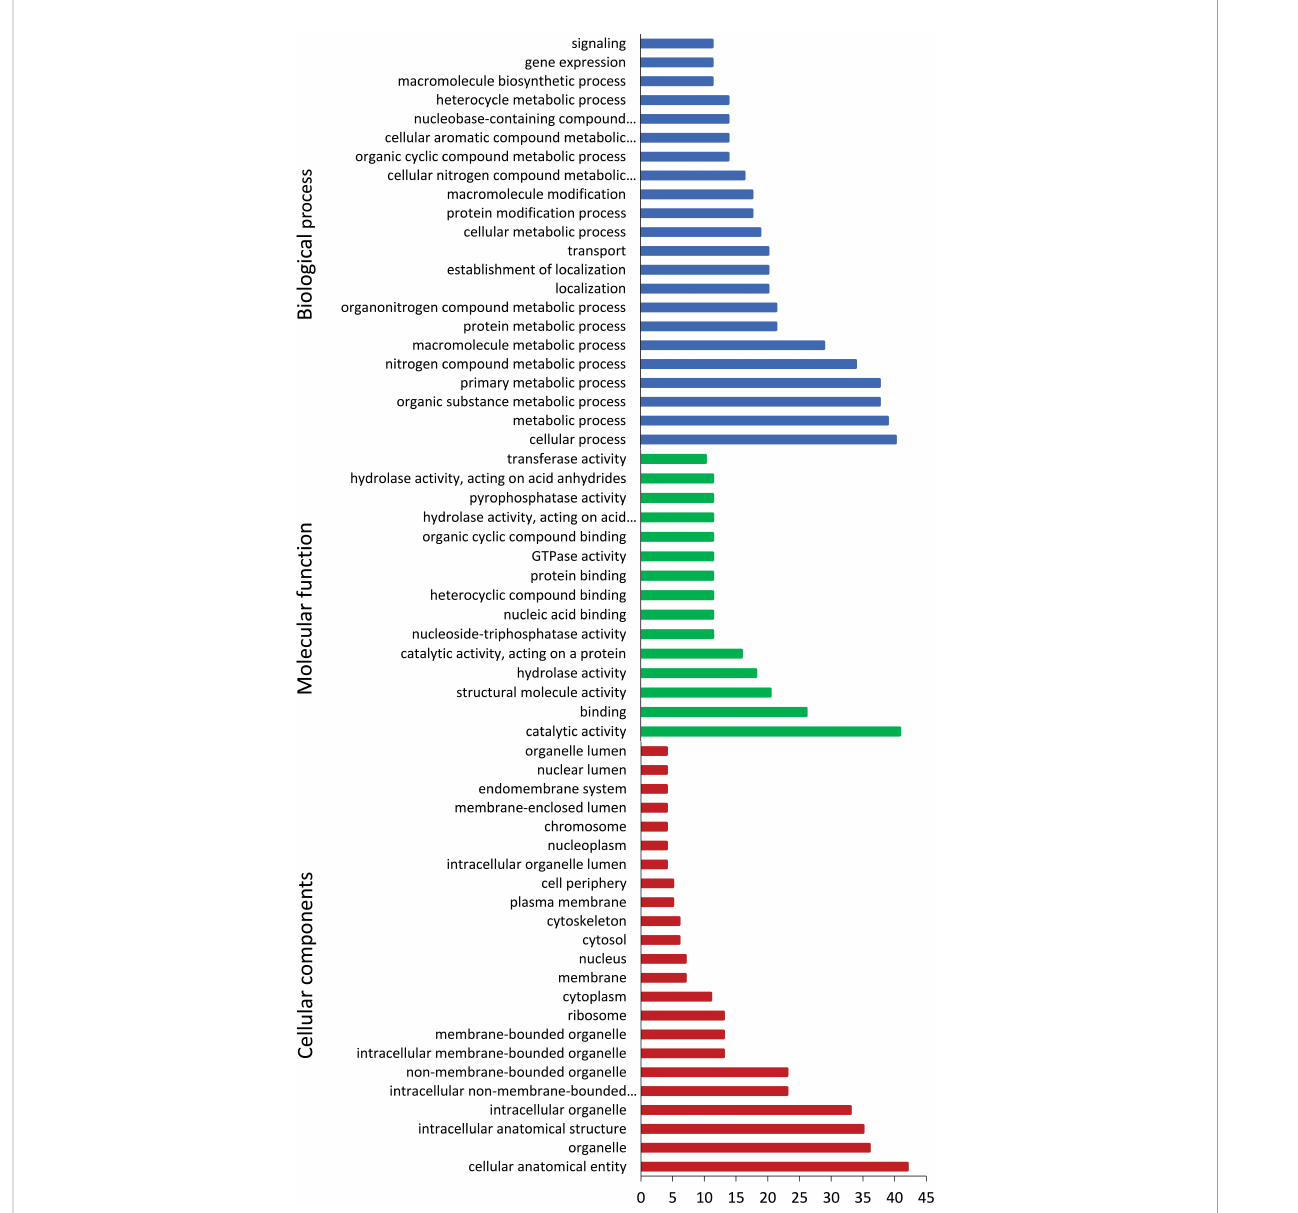
FIGURE 4 Gene ontology annotation of Tetracapsuloides bryosalmonae in vivo -induced genes. Most frequent level 2 GO terms in T. bryosalmonae IVI genes, separated for the GO domains; biological process, molecular function, and cellular